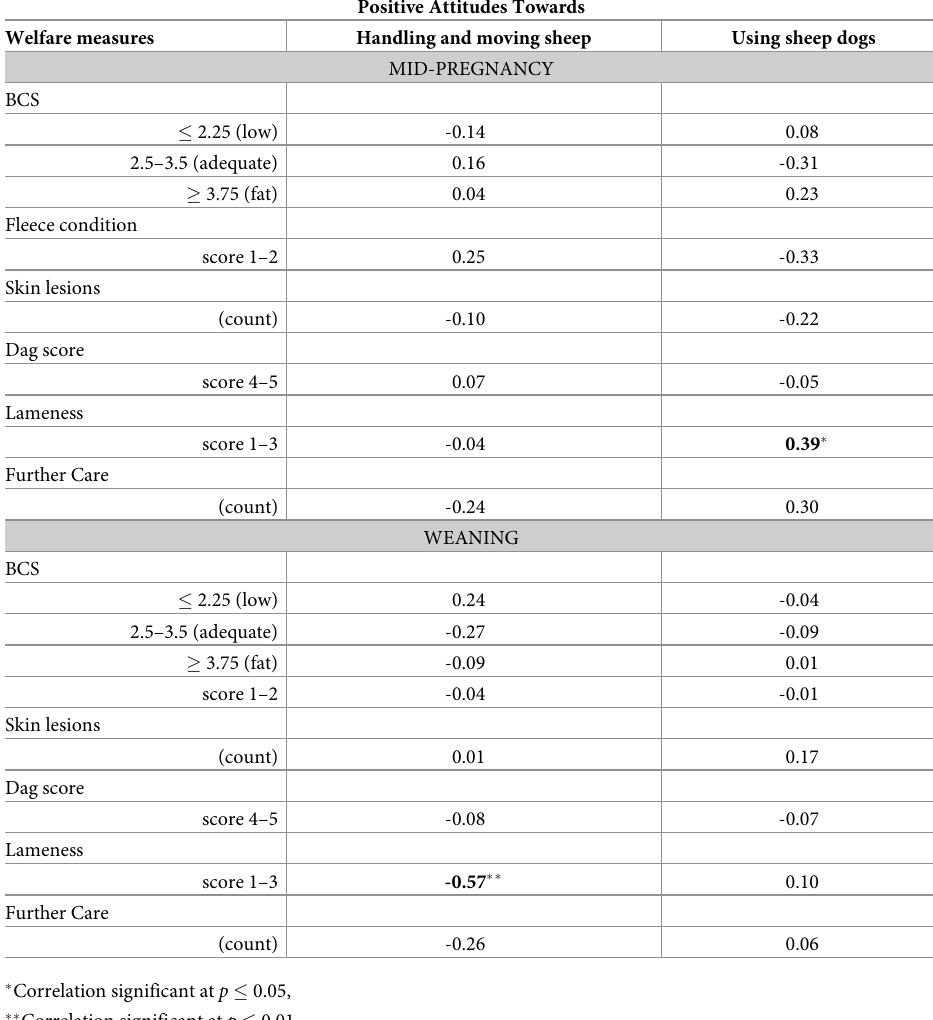
Table 6. Spearman’s rank correations between general attitudes towards handling sheep and welfare